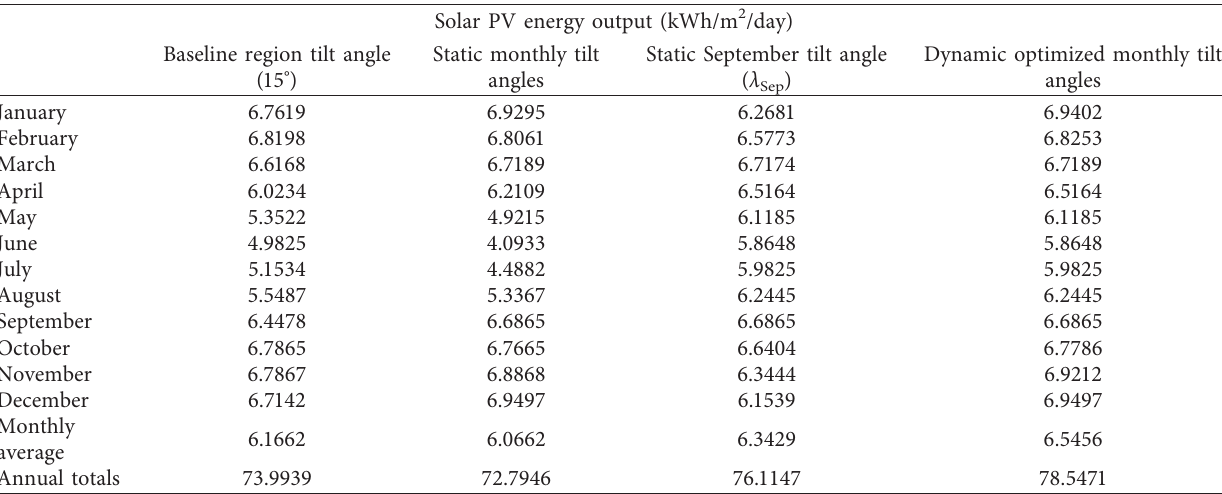
Table 5: Solar PV energy output at the four defined configurations.